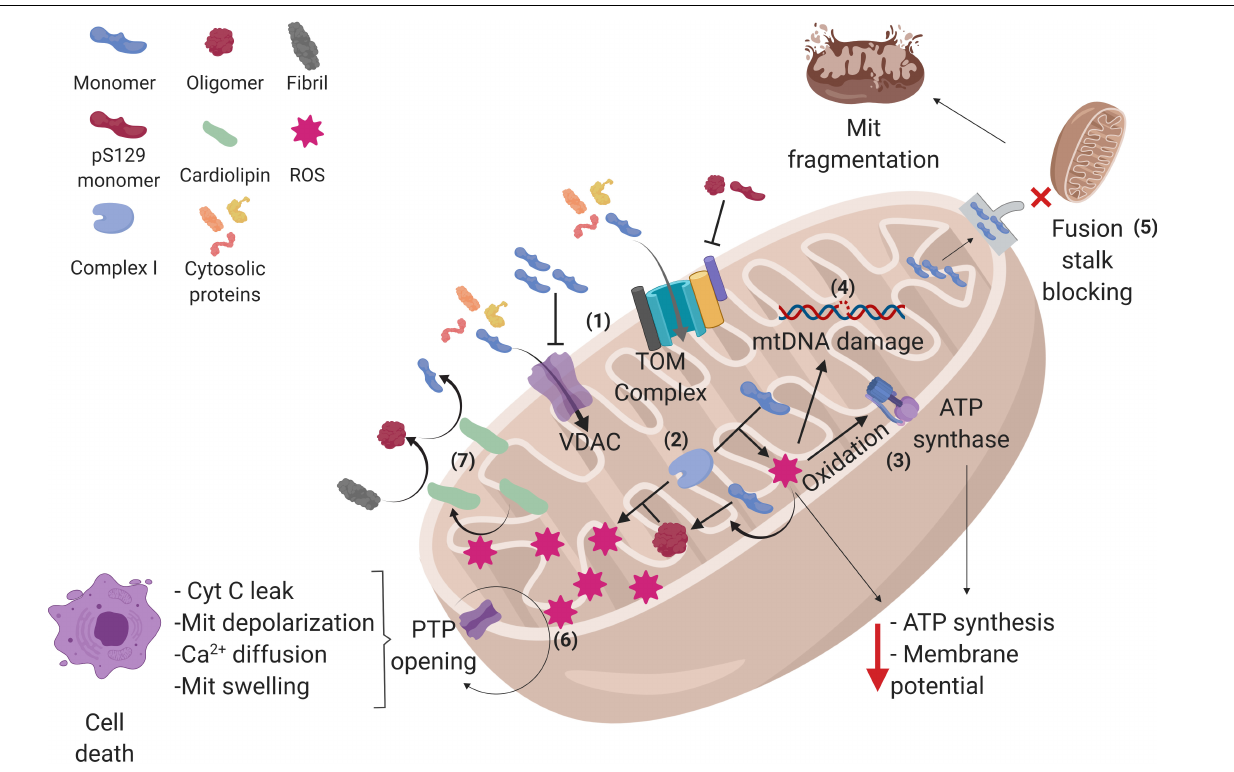
FIGURE 2 | Alpha-synuclein conformations and its interactions in mitochondria. (1) Alpha-synuclein ( α -syn) monomers enter the mitochondria (Mit) through translocase of the outer membrane (TOM) and voltage-dependent anion channels (VDAC), but oligomers and pS129- α -syn on TOM and α -syn accumulation on VDAC can inhibit the protein import into the mitochondria, affecting the process that depends on cytosolic proteins. (2) Once inside, α -syn can interact with complex I of the electron transport chain, raising reactive oxygen species (ROS) production within the mitochondria, and favoring the aggregation of α -syn monomers into oligomers, which in turn produces more ROS, creating a cycle where α -syn aggregation and ROS production exacerbate each other. (3) The increased amount of ROS oxidizes the ATP synthase β -subunit, diminishing mitochondrial ATP levels as well as (4) damaging mitochondrial DNA (mtDNA), which may lead to an altered expression of mitochondrial genome-encoded genes. (5) α -syn monomers can also block mitochondrial fusion stalk, producing mitochondrial fragmentation. (6) In addition, α -syn induces the opening of permeability transition pore (PTP), allowing cytochrome C (cyt C) leak, depolarization, calcium diffusion, and swelling of the mitochondria, leading to cell apoptosis. (7) Certain stress events such as ROS can stimulate the translocation of cardiolipin from the inner membrane to the outer membrane, where it acts as a buffer for aggregative synuclein forms. See the text for further details. Created with